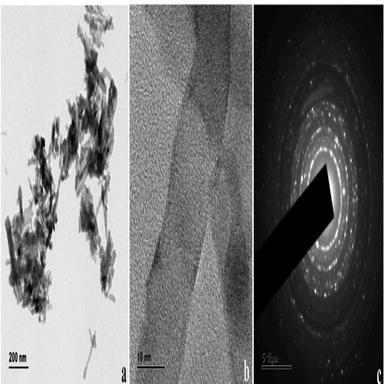
(a) Transmission electron micrographs (TEM) (b) High resolution TEM (c) SAED pattern for Sr2MgSi2O7:Dy3þ(7 mol%) NPs.